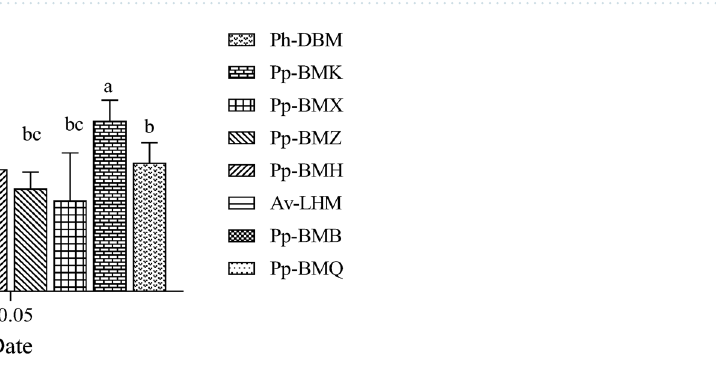
Figure 12. The symptoms of stem necrotic lesion spots disease in inoculated stems of Luobuma. ( a ) stem symptoms of A. venetum 5 days after inoculation, ( b ) stem symptoms of A. venetum 13 days after inoculation and ( c–e ) necrosis lesions on the stems of Luobuma.